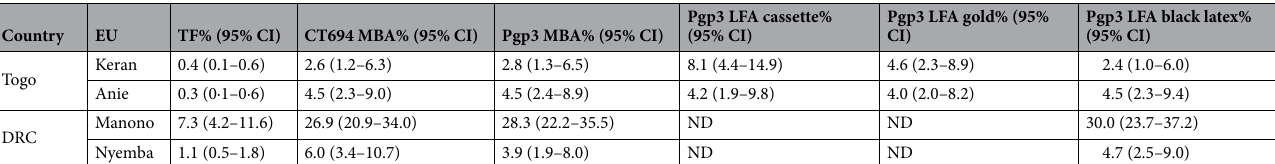
Table 1. Age-adjusted prevalence of trachomatous inflammation—follicular (TF) and anti-Ct antibodies by different immunoassays. EU evaluation unit, CI confidence interval, Pgp3 plasmid gene product 3, Ct